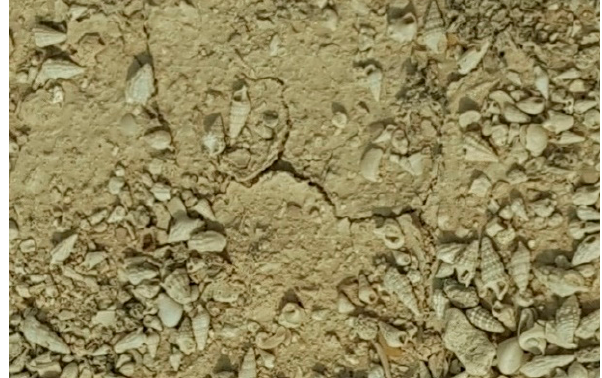
Figure 8. The use of subaan as a cover for courtyards and public spaces.